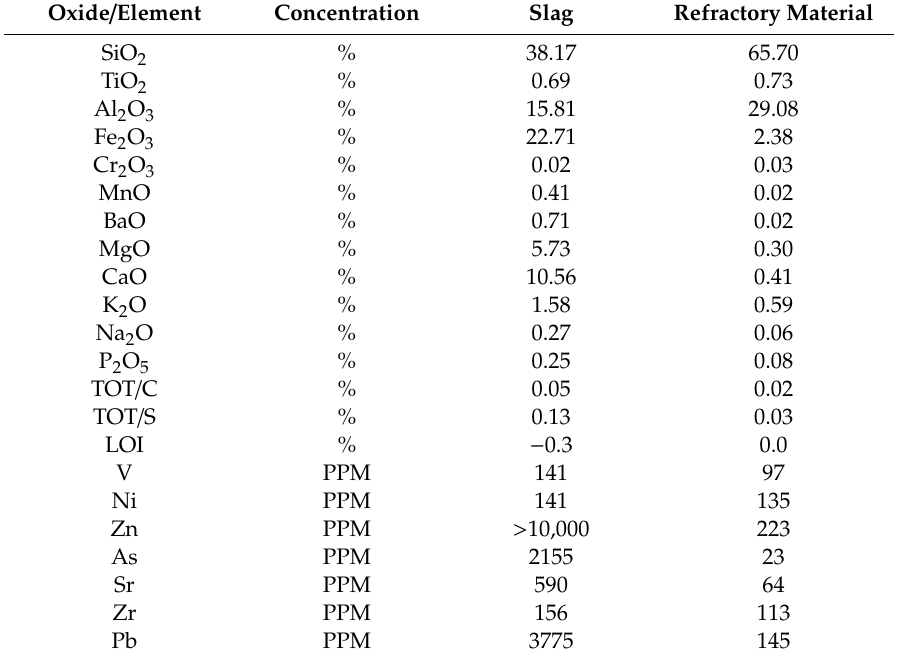
Table 2. Chemical composition of slag and refractory material. Oxide /